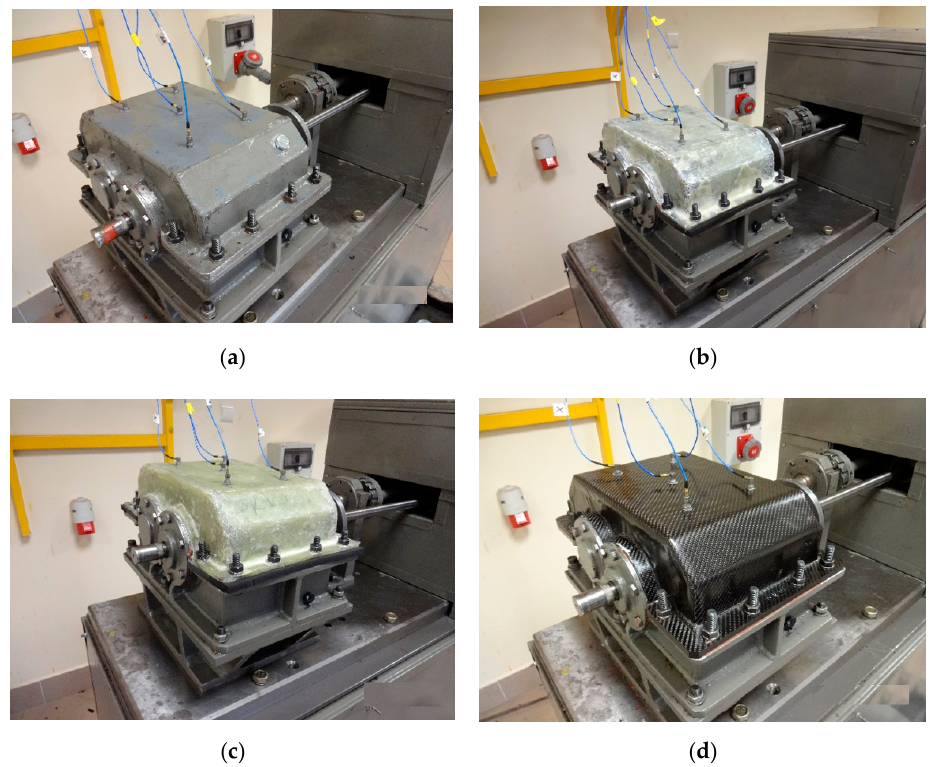
Figure 2. View of housings mounted on the stand together with measuring transducers [59]: ( a ) Steel housing; ( b ) K_1 housing; ( c ) K_2 housing; ( d ) K_3 housing.